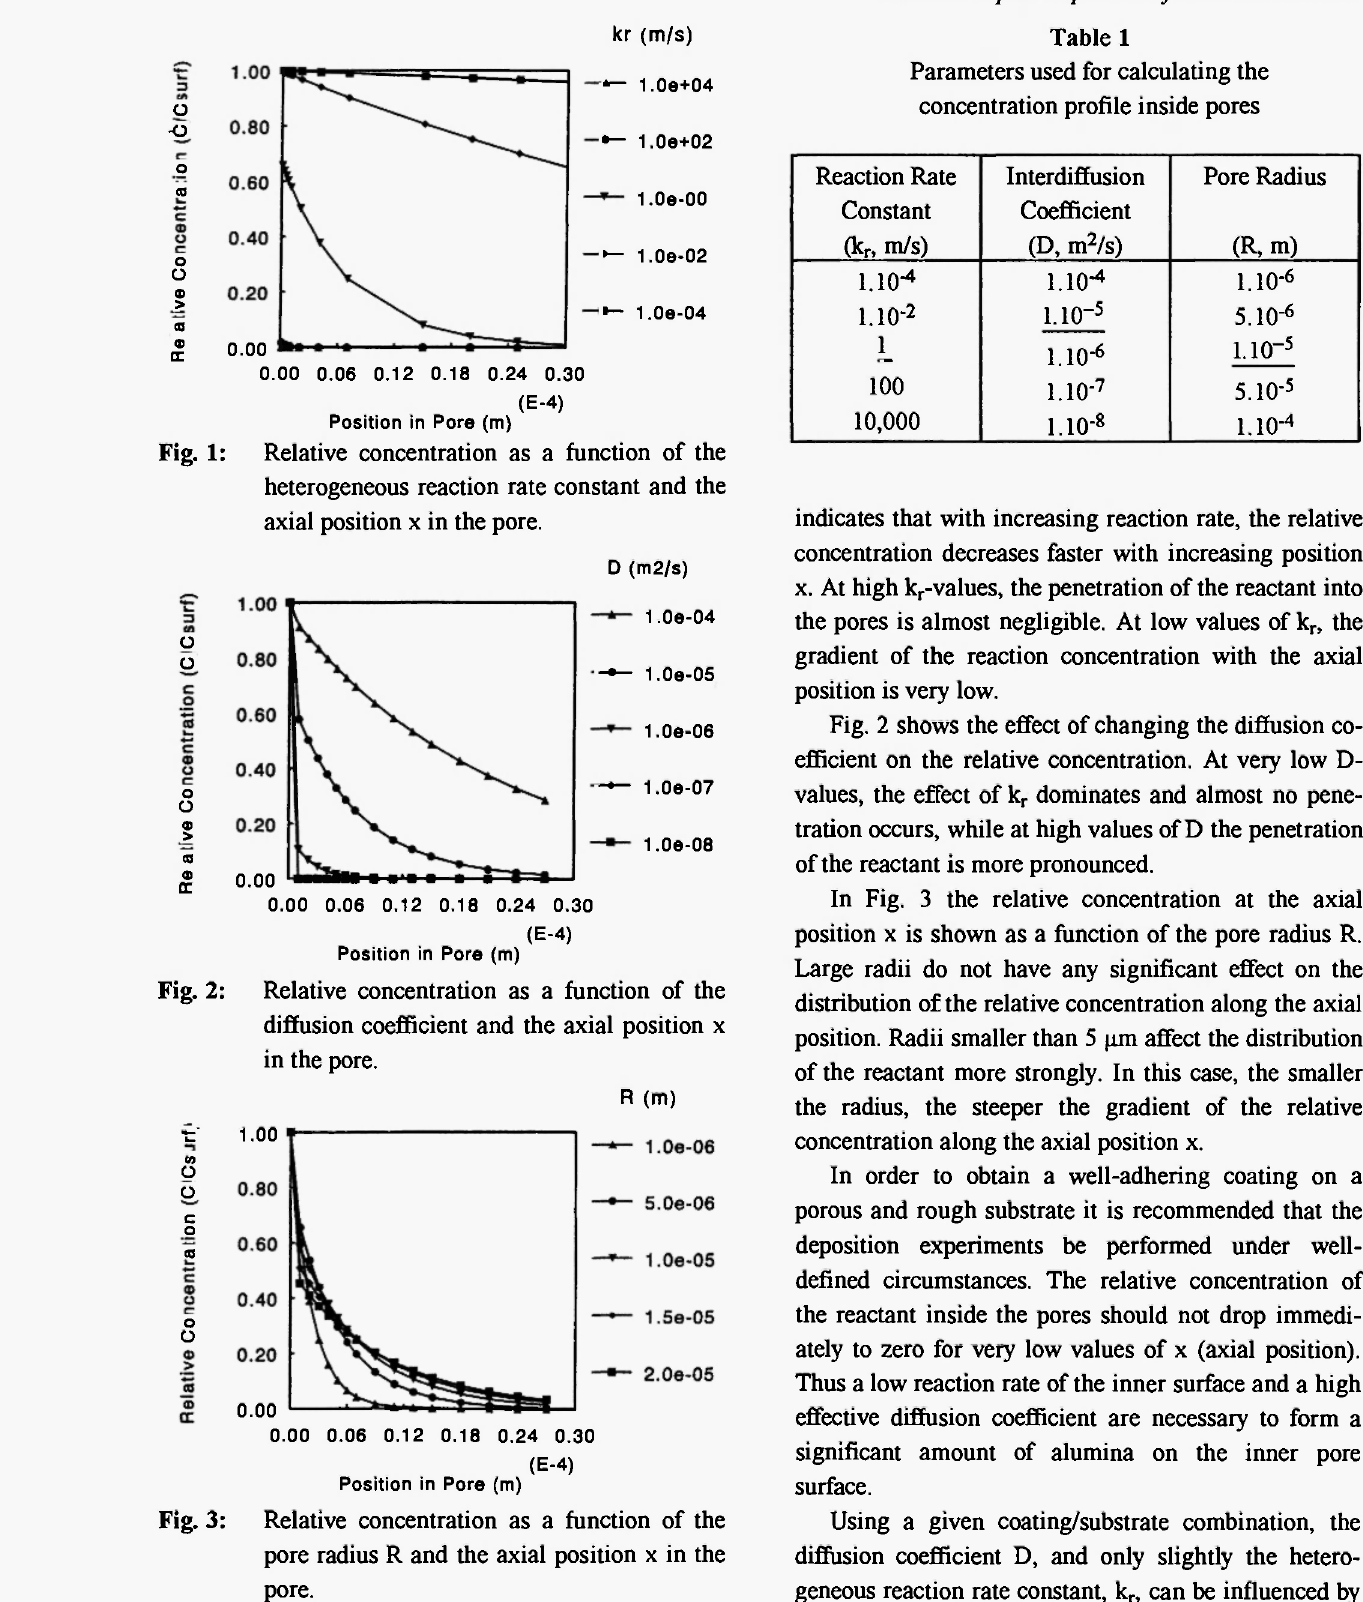
Fig. Relative concentration as a function of the pore radius R and the axial position χ in the pore.